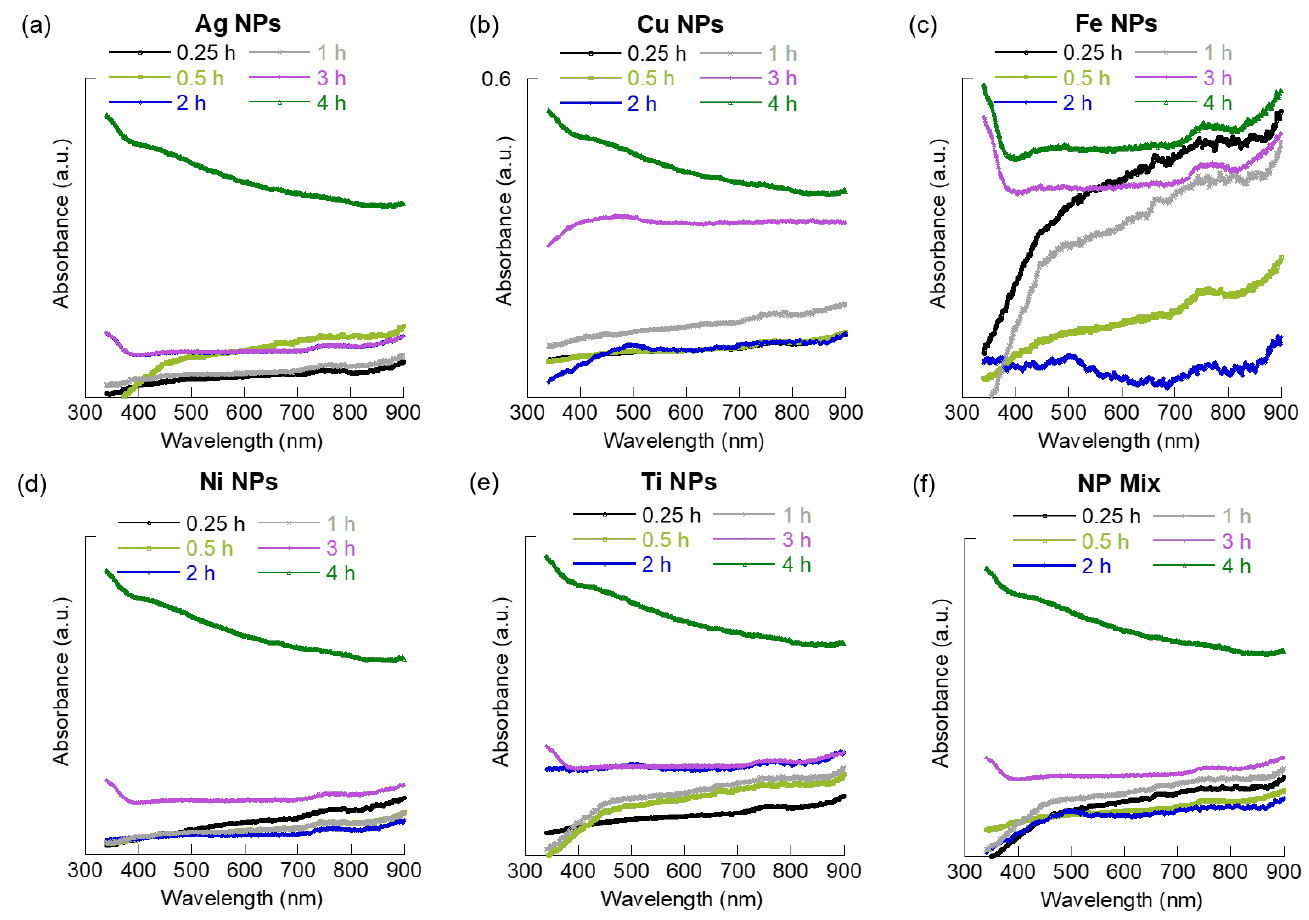
Figure 1. UV-Vis plots of the different nanoparticle samples at varying sonication times. ( a ) Ag, ( b ) Cu, ( c ) Fe, ( d ) Ni, ( e ) Ti, and ( f ) aqueous co-existed MNPs mix.